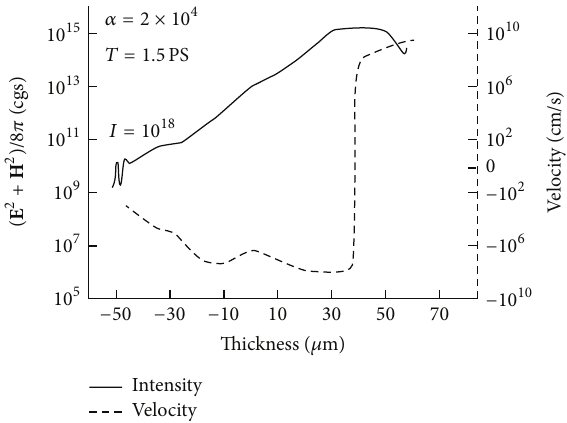
Figure 1: Generation of blocks of deuterium plasma moving against the neodymium glass laser light (positive velocities V to the right) and moving into the plasma interior (negative velocities) at irradiation by a neodymium glass laser of 10 18 W/cm 2 intensity onto an initially 100eV hot and 100 𝜇 m thick bi-Rayleigh profile with minimum internal reflection. The electromagnetic energy density ( E 2 + H 2 )/(8 𝜋 ) is shown at the same time of 1.5PS after start of the constant